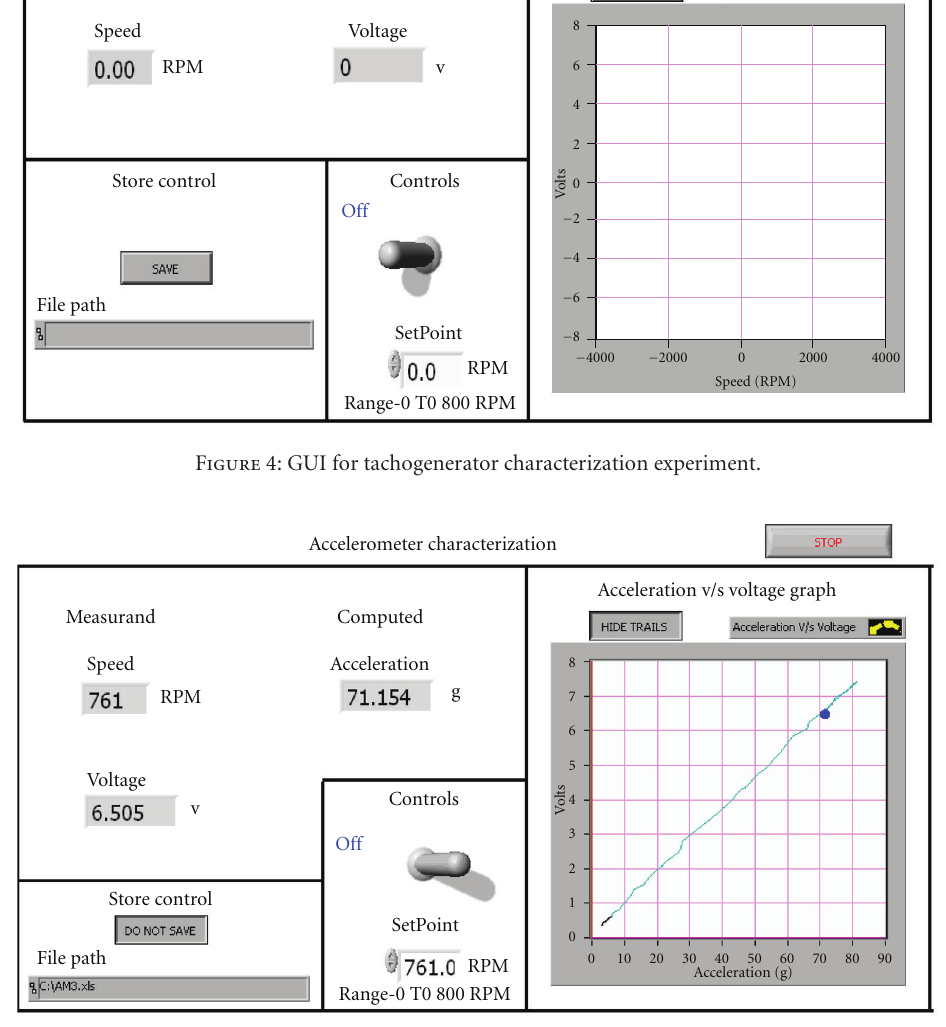
Figure 5: Snapshot of accelerometer characterization experiment in Live